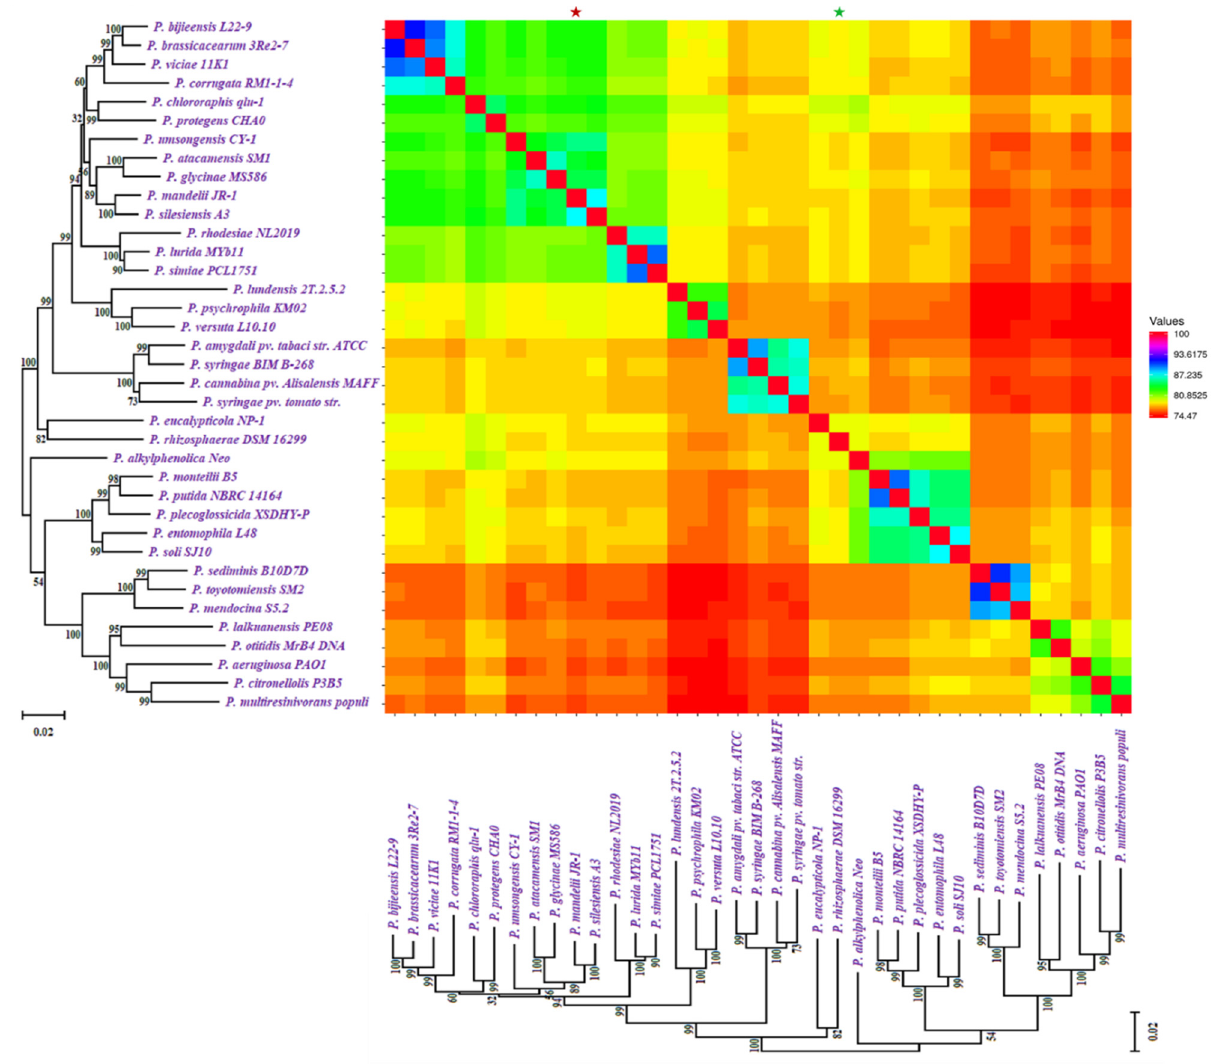
Figure 3. Similarity across the whole genomes of Pseudomonas species. Comparison follows the same sequence as the phylogenetic tree in Figure 1. All comparisons between a genome and itself take place on a line that runs from the top left to the bottom right corners of the genome. The numerator for each comparison is the number of comparable genes between two genomes, whereas the denominator is the genome represented by each column. The smallest genome is marked with a * (green), and the biggest genome is marked with a * (red).